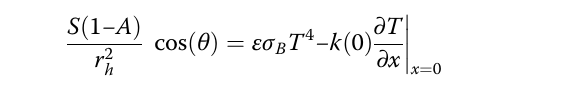
as the upper boundary condition at x = 0. Here, T is kinetic temperature, σ B the Stefan-Boltzmann constant, t is time, x is depth, S is the solar constant, A is the bond albedo, r h is the heliocentric distance in units of AU, and Table 1 Parameters used in this study (Wada et al. 2018; Watanabe 2019) Property Symbol Value Units